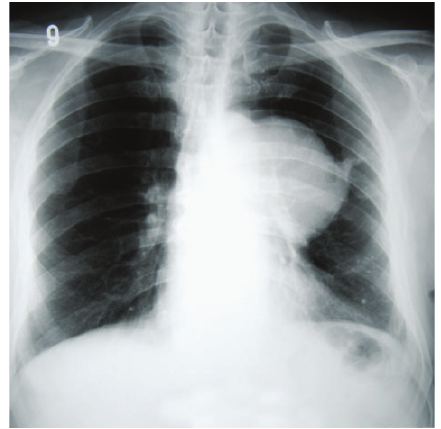
Figure 2: A well-circumscribed mass at the middle lung field.